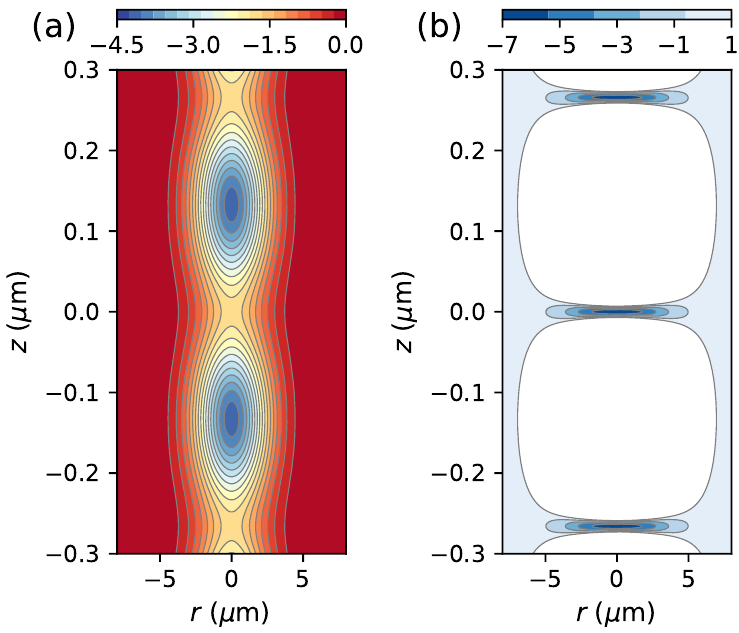
Figure 7. Calculated bichromatic optical potentials for 138 Ba + ( a ) and 87 Rb ( b ) for a combination of a single NIR beam and a partially retro-reflected VIS OTD. The assumed reflected power is 5 = 469mW, the NIR ODT power is P = 106mW, all beams are % of the input power P IN NIR VIS focused to a 1/ e 2 beam waist radius of w 0 = 3.7 µ m. The numeric values of the potentials U Ba / k B (in mK) and U Rb / k B (in µ K) are mapped to a false color representation. The potentials show the expected separation between the Ba + and Rb allowing for a drastic reduction of their wavefunctions’ overlap. Since the effective Ba potential can be shifted with sub-wavelength precision by adjusting the electrostatic trapping potential while the potential for Rb remains unchanged, the ion–atom overlap can be dynamically varied, allowing to tune the elastic collision rate, as well as the ratio of elastic to inelastic